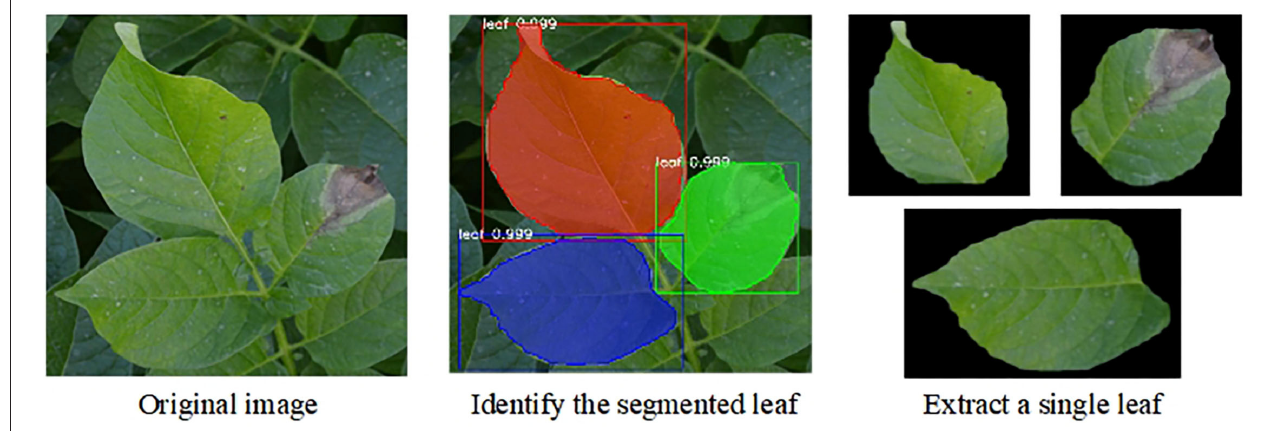
FIGURE 4 | The potato leaves segmented by Mask R-CNN and the single leaf under the black background extracted in the original image.